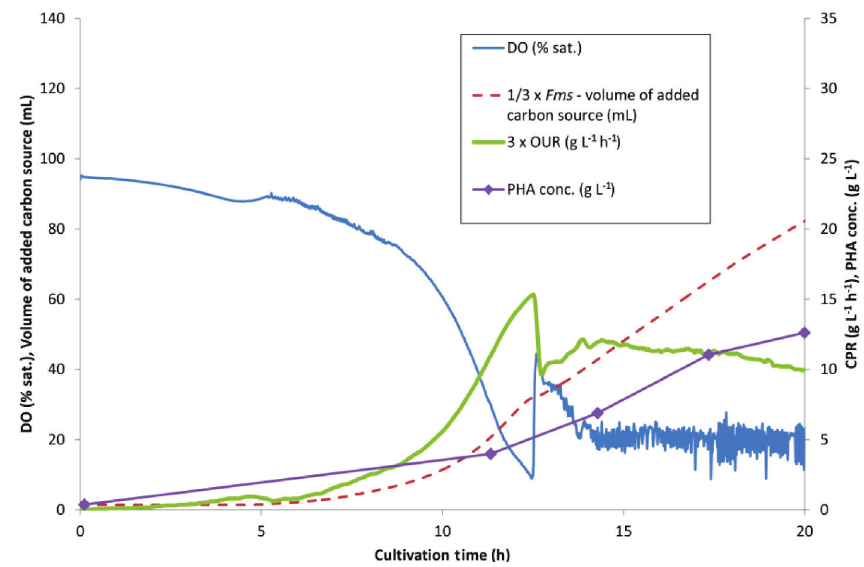
Fig. 2 – Cultivation 5 (0 – 20 h), carbon source feeding using sequence of strategies (4, 2,